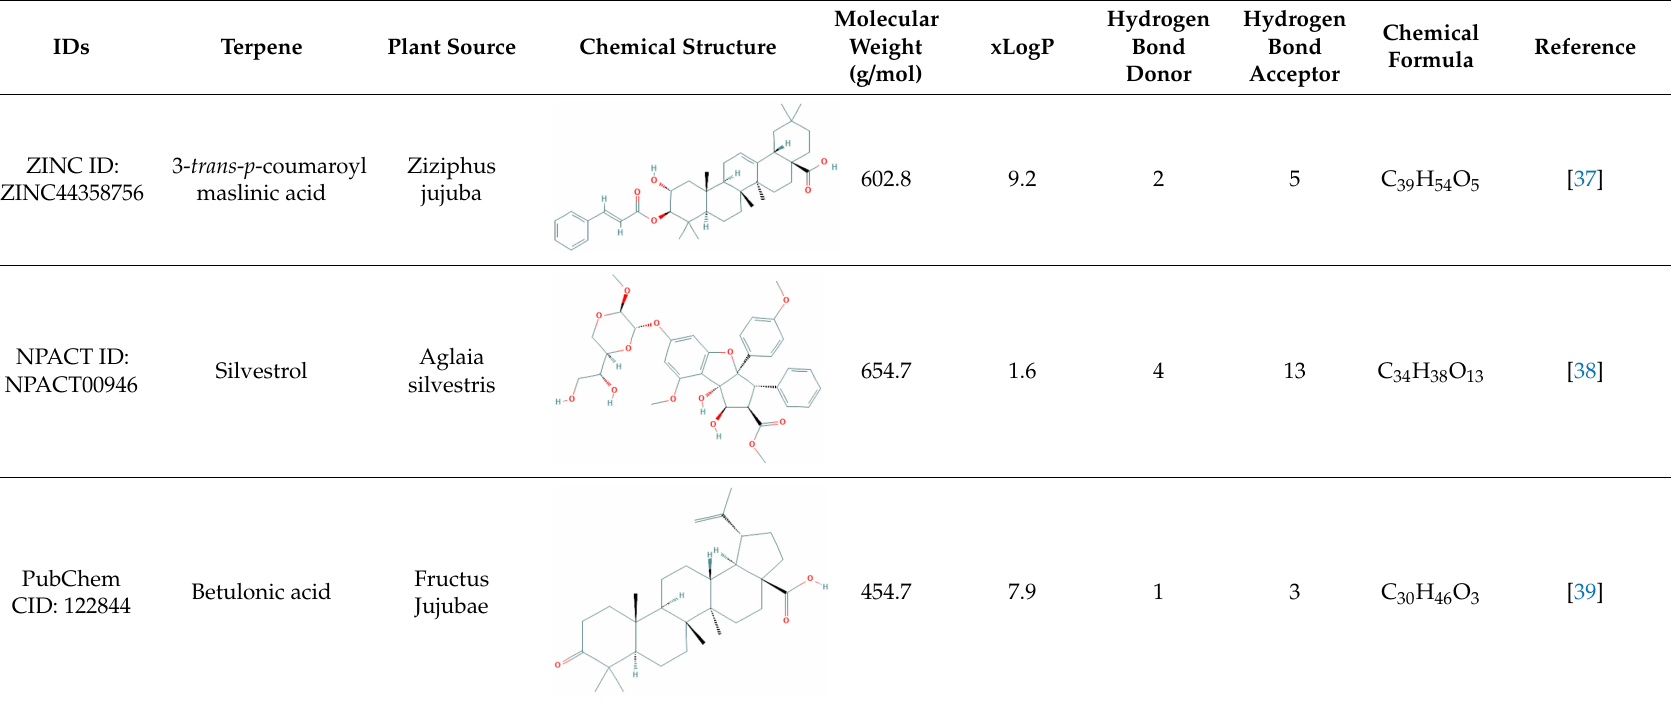
Table 1. Details of finally selected terpenes